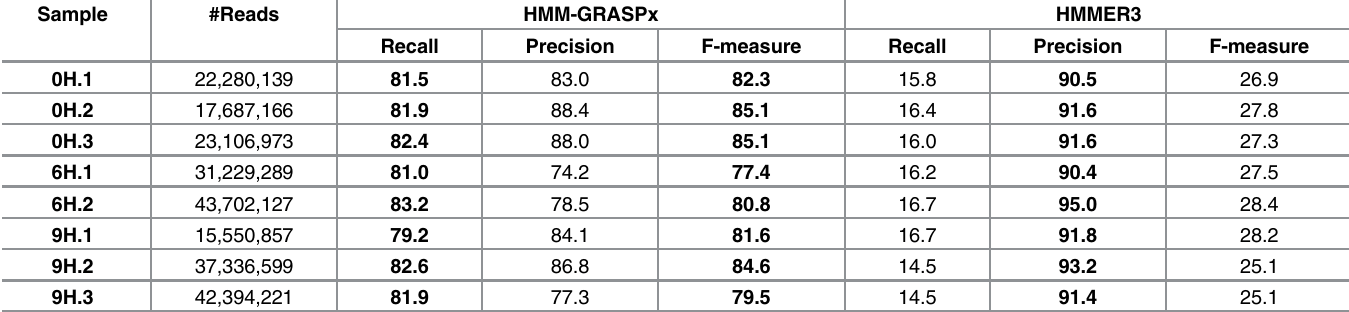
Table 3. Performance of HMM-GRASPx and HMMER3 for searching biosynthetic protein family profiles against the in vitro human oral plaque bio- film MT data sets. Sample